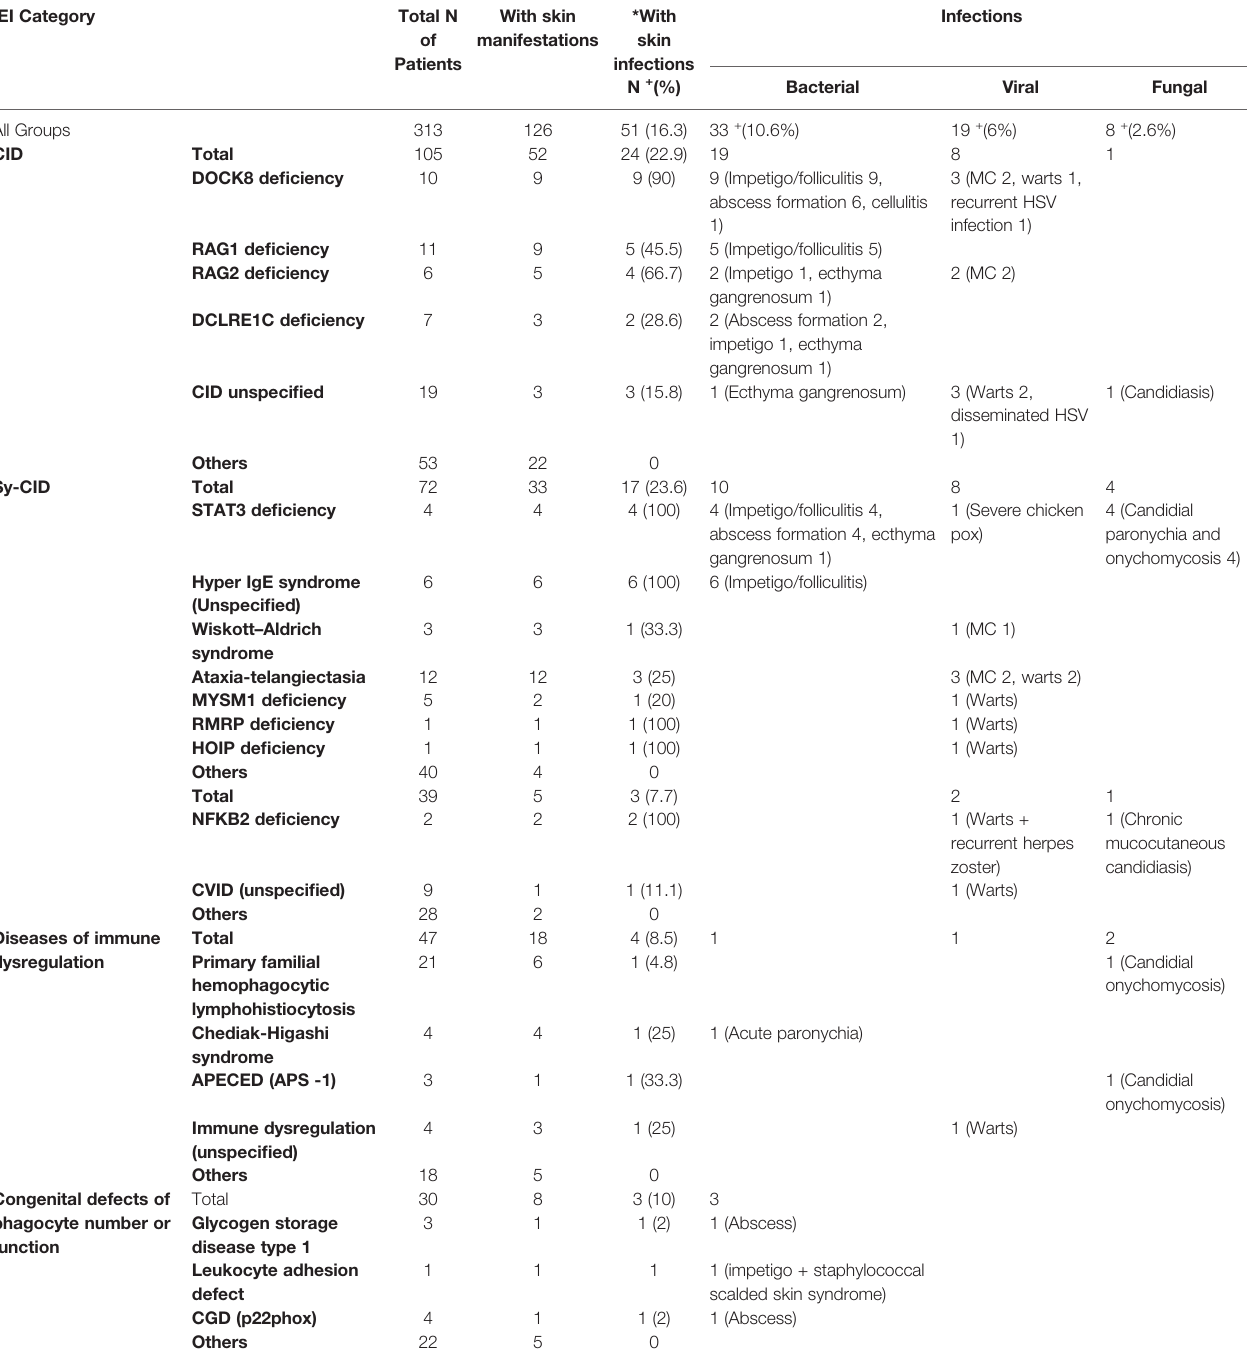
TABLE 4 | Distribution of skin infections among 313 IEI children registered in the KNPIDR. IEI